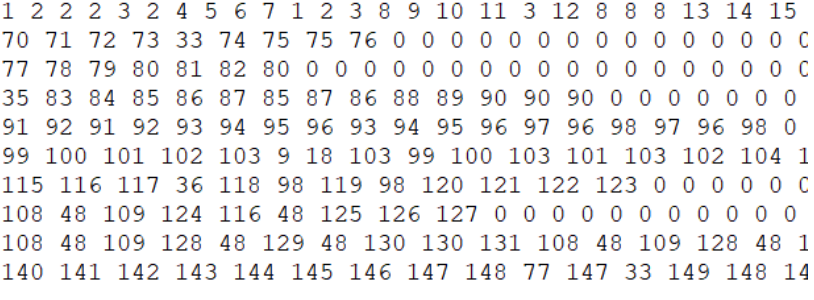
Figure 6. PowerShell Sequence Data.